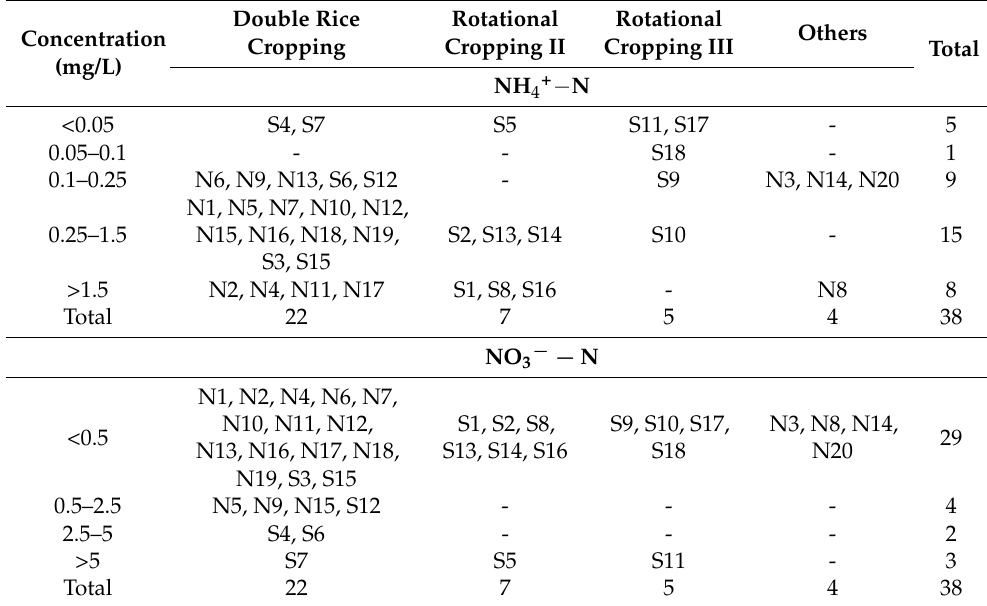
Table 1. The distribution of ammonium–N and nitrate–N in different concentration ranges of all monitoring wells under various cropping